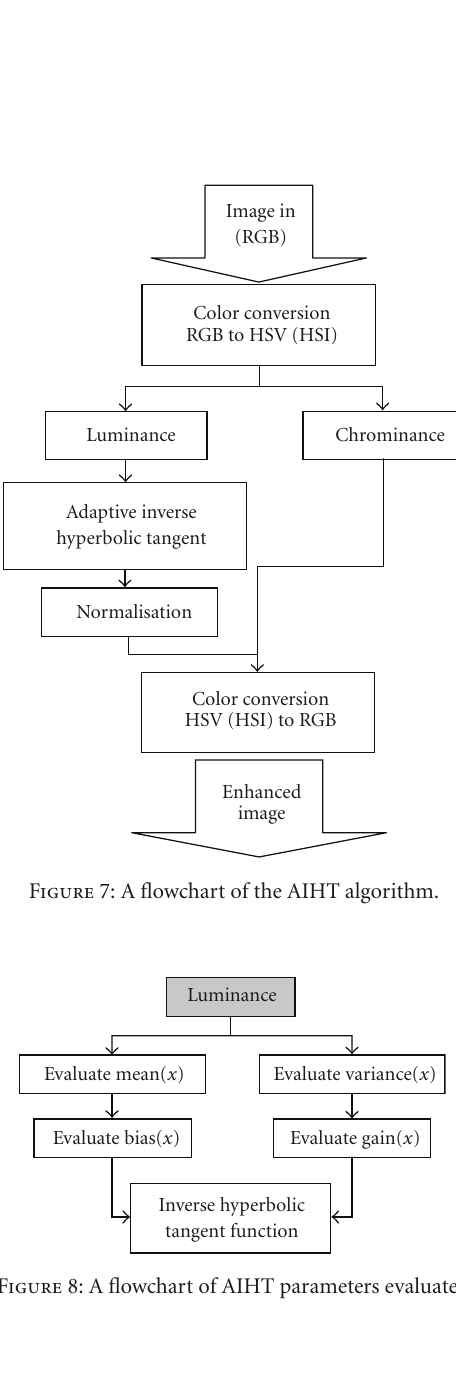
that each value in the input image can have several values in the output image so that objects in the original scene lose their correct relative brightness values. There are two methods of nonlinear contrast enhancement.